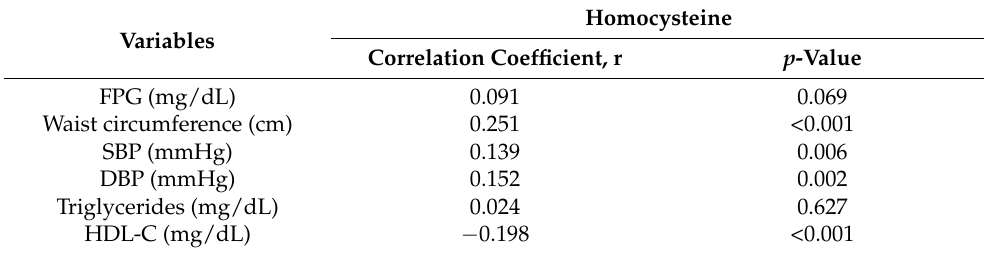
Table 4. Pearson’s correlation between homocysteine and components of metabolic syndrome.